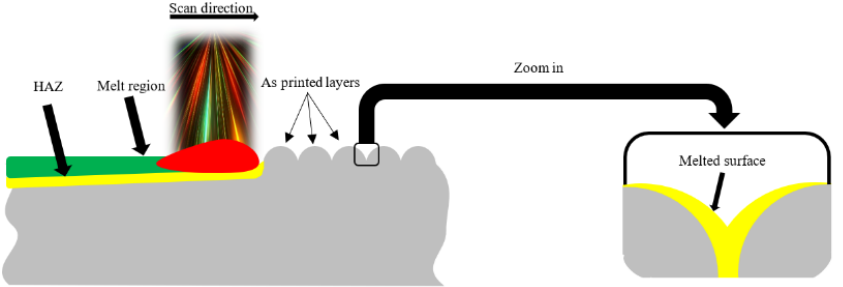
Figure 1. The laser polishing process.